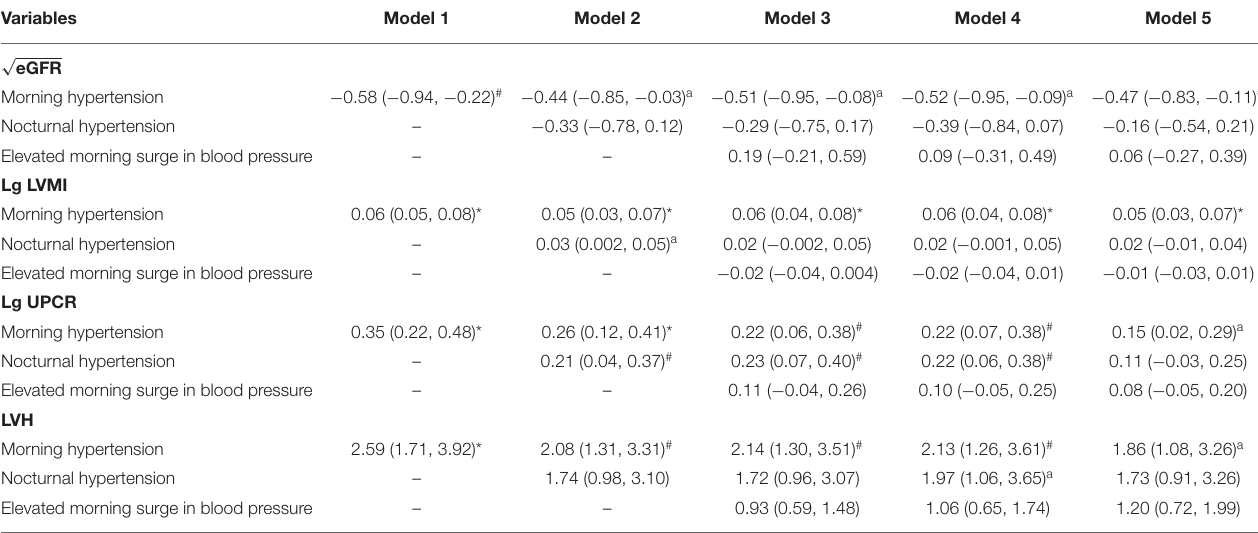
TABLE 4 | Multivariate linear regression and binary logistic regression analysis of BP indexes and target organ